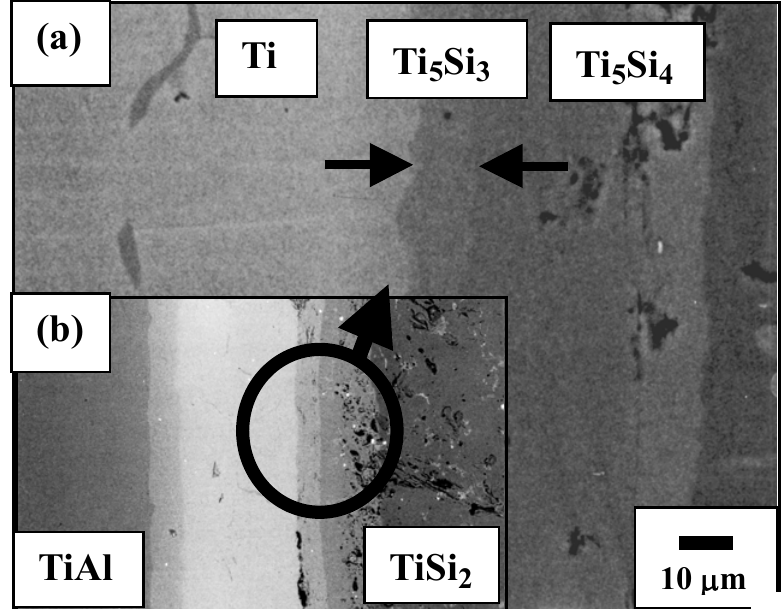
/Ti/TiAl reaction couple annealed for 1,100 ° C for 400 h Figure 17. BSE image of TiSi 2